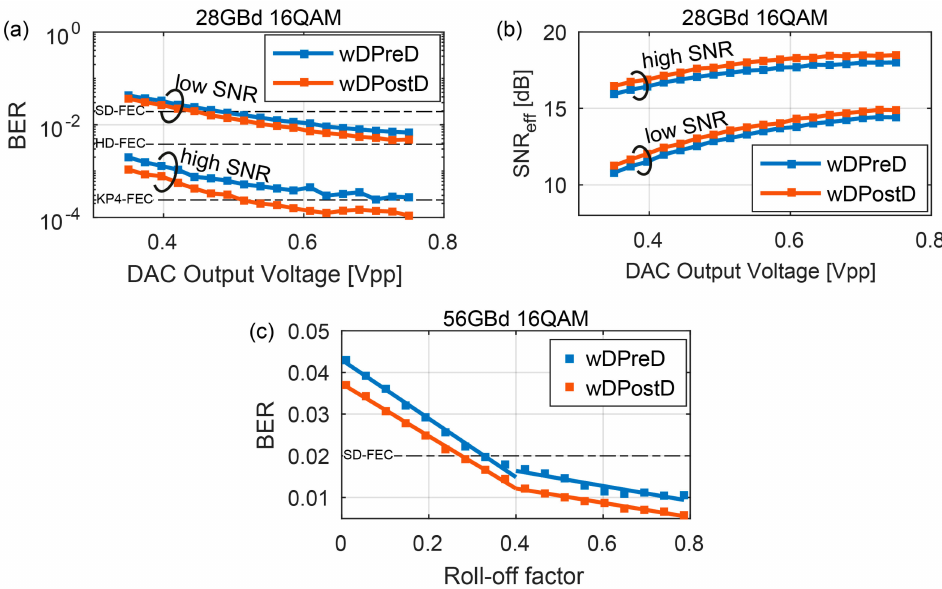
Figure 6. Influence of DPreD and digital post-distortion (DPostD) on the performance of an optical coherent 16QAM signal. Forward error correction (FEC) limits for KP4-FEC (BER: 2 × 10 − 4 , hard-decision FEC (HD-FEC) (BER: 3.8 × 10 − 3 ), and soft-decision FEC (SD-FEC) (BER: 2 × 10 − 2 ) are given. ( a ) BER over DAC driving voltage of a 28-GBd signal measured in the low- and high-SNR regime. ( b ) SNR over DAC driving voltage for the measurements in ( a ). ( c ) BER over roll-off factor of a 56-GBd signal. The solid line is a linear interpolation of the measurement values below and above a roll-off factor of 0.4. BER: bit error ratio; DAC: digital-to-analog